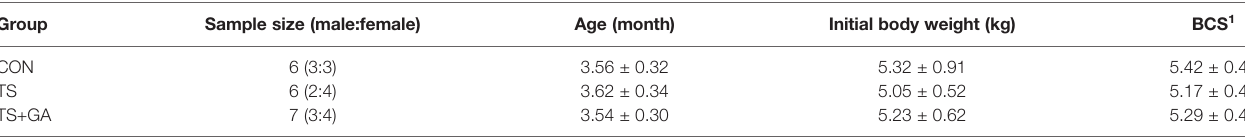
TABLE 1 | Detailed information of beagle dogs in this study. Group